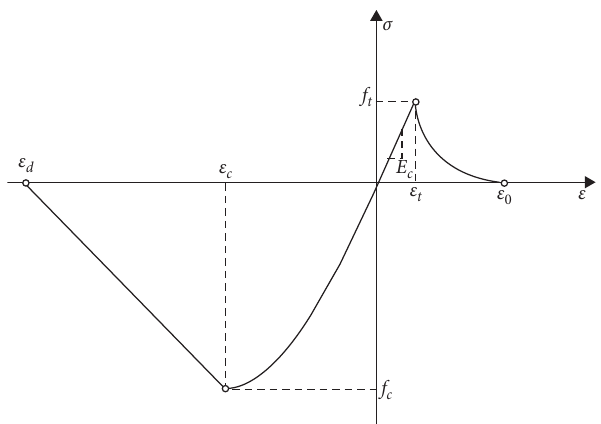
Figure 23: Constitutive model for concrete (ATENA).